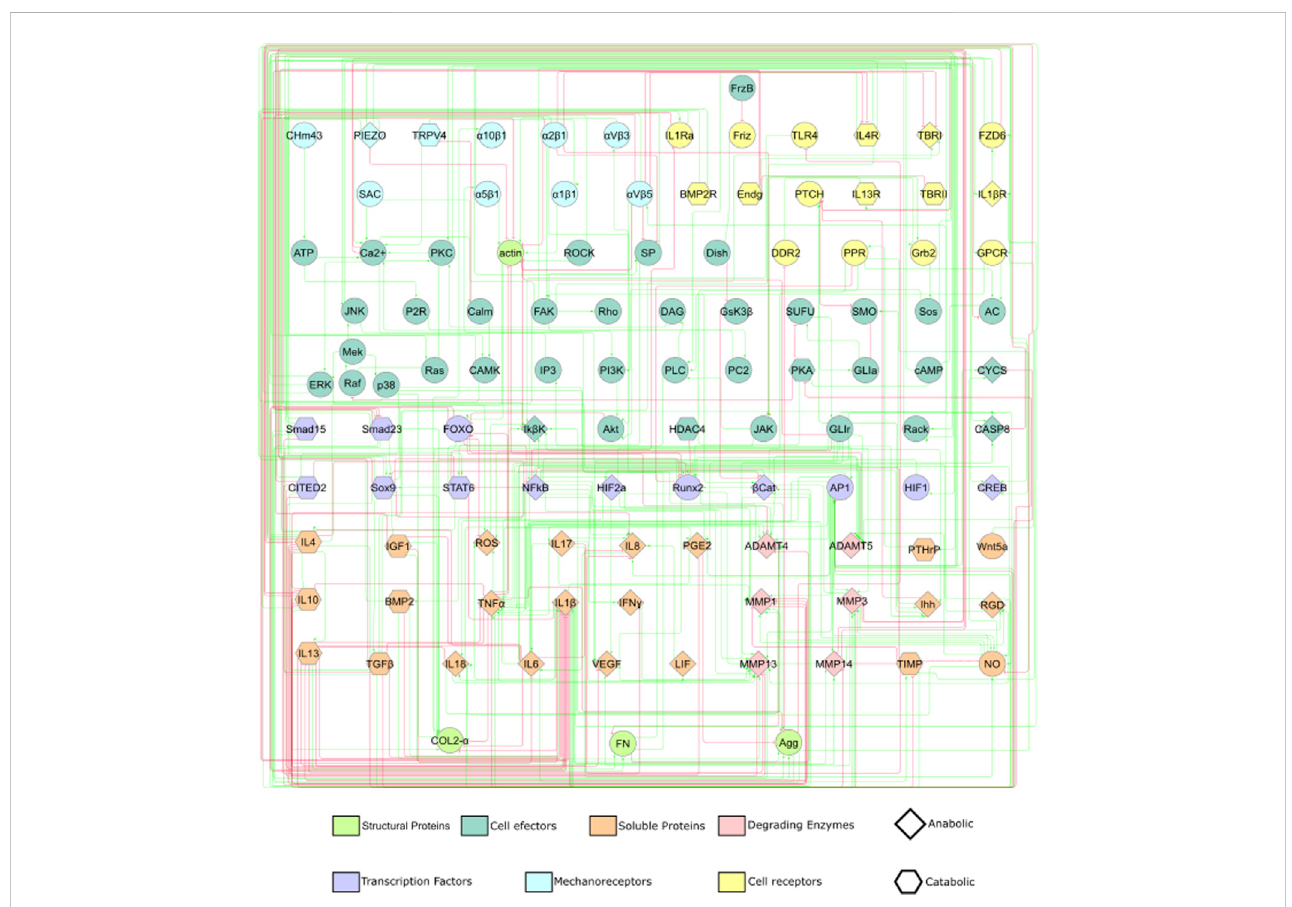
FIGURE 1 A staticgraph of the interactomedepicting the mechanotransduction processes of a chondrocyte is shown. Red edges inhibit, and green edges activate the target nodes. The nodes of the NBM represent molecules involved inthe main mechanotransduction pathways of chondrocytes. The nodes according to their function within a signalling pathway are deferentially represented (see